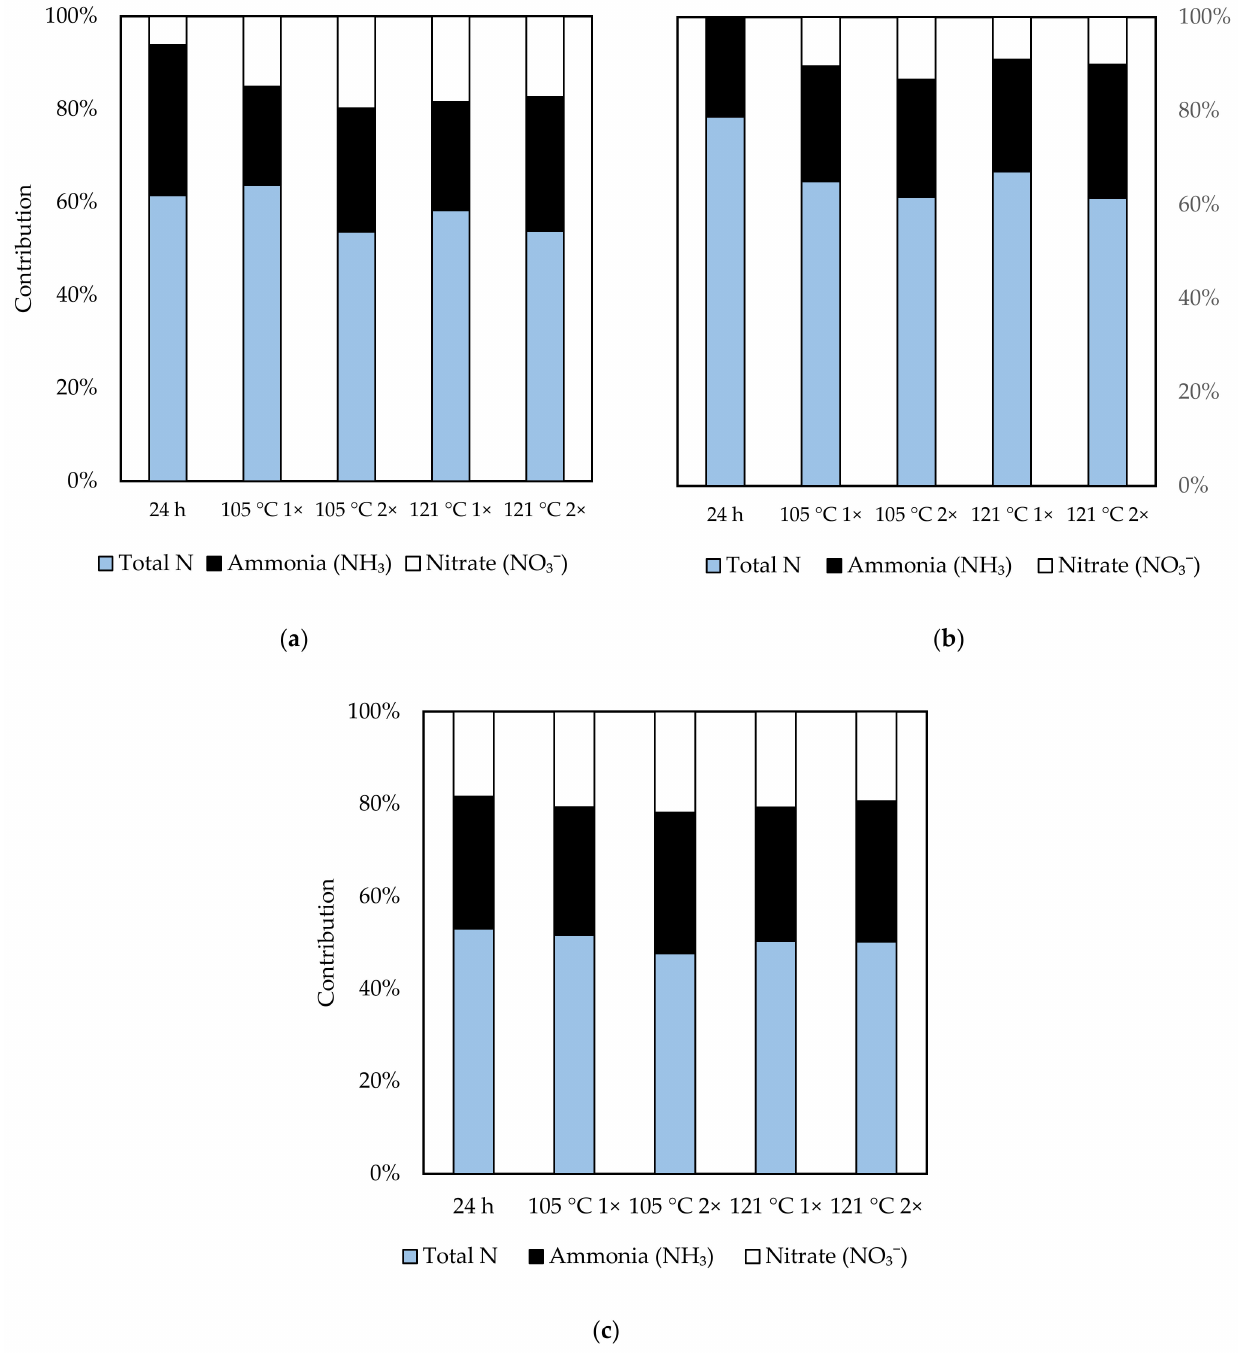
Figure 1. Total contribution of ammonia, NH 4+ and nitrate, NO 3 to total organic N for ( a ) Chini Forest Reserve ( b ) Langkawi Island and ( c ) Kenyir soil, respectively. Bars represent average value of concentrations at ( n =